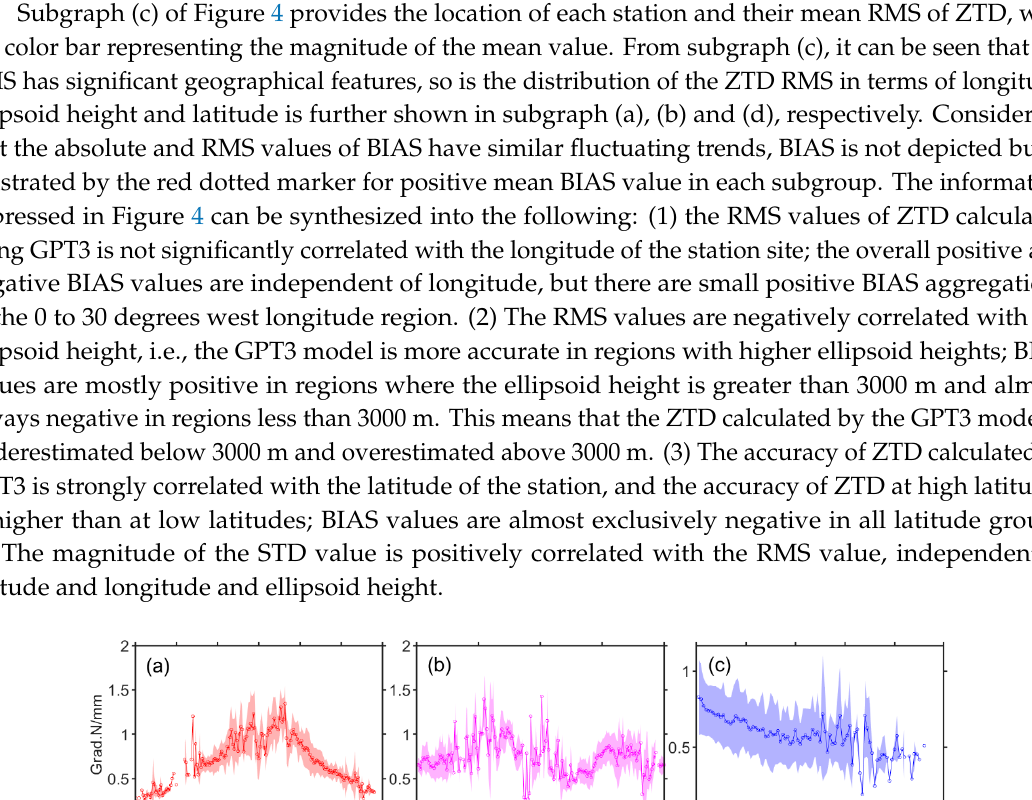
Table 1. Correlation coefficient.